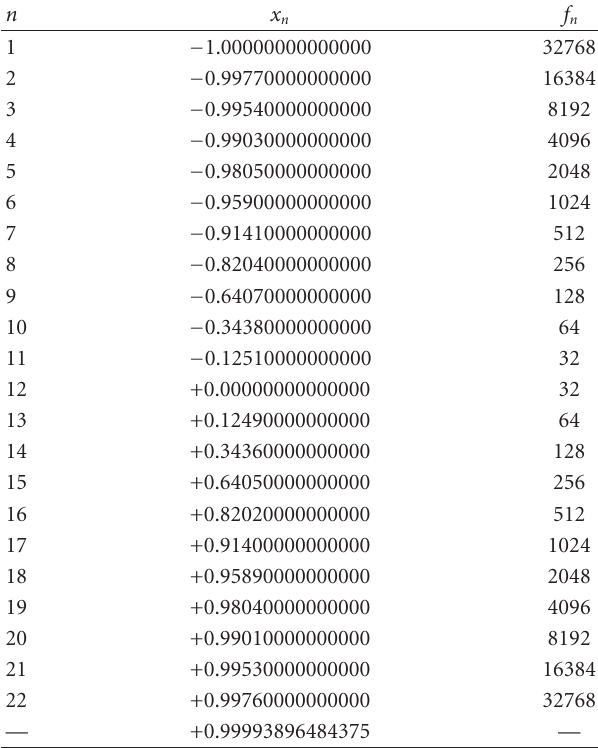
Table 1: Frequency assignment for sampling scheme α